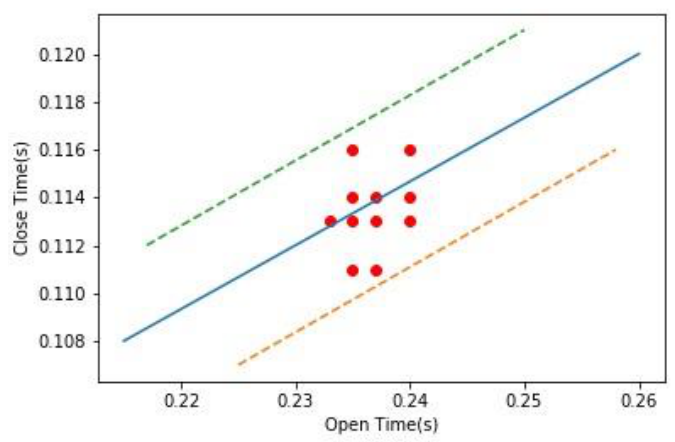
Figure 6. Create model using linear regression.